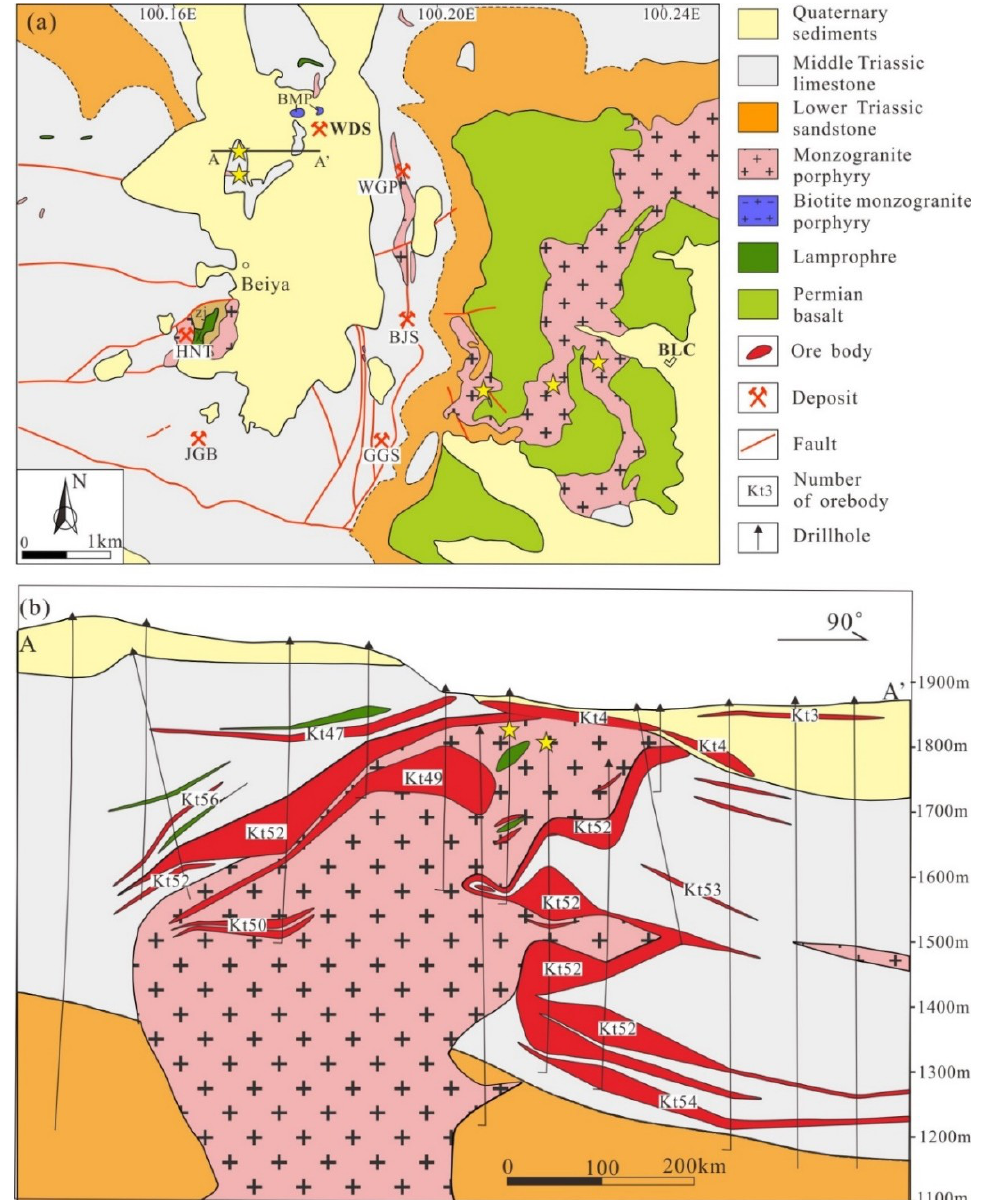
Figure 2. Geology of the Beiya Au deposit ( a ) and representative crosssection of Wandongshan district showing the location of the skarn ore body ( b ) [23]. WDS: Wandongshan district; HNT: Hongnitang district; JGB: Jin’gouba district; WGP: Weiganpo district; GGS: Guogaishan district; BJS: Bijiashan district; BLC: Bailiancun district.